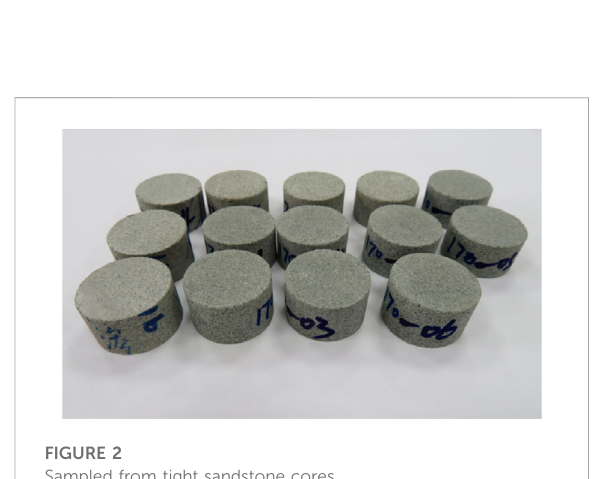
FIGURE 2 Sampled from tight sandstone cores.